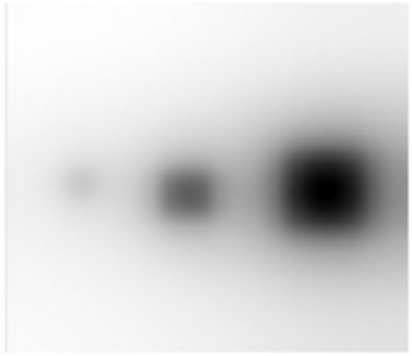
Figure 3. Thermal image obtained from the modelling runs showing detection of the defects.